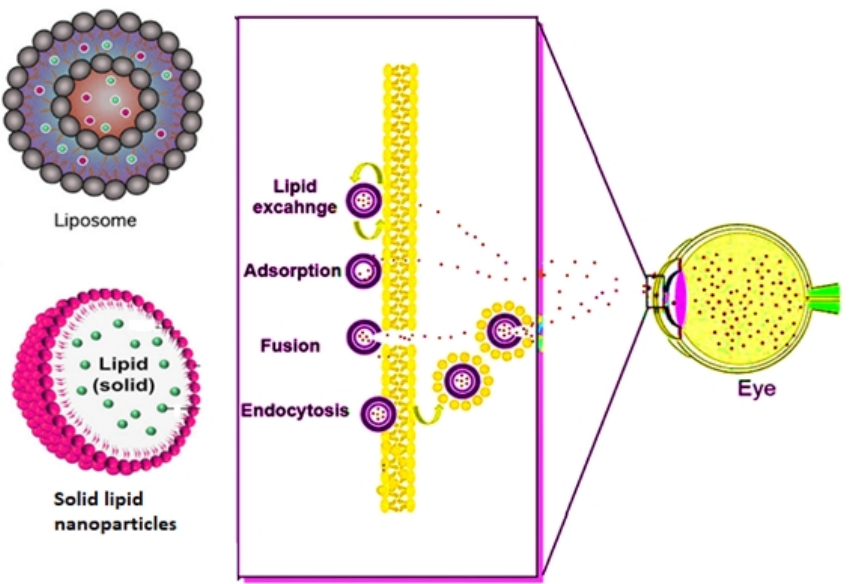
Figure 3. Mechanism followed by lipid and polymeric nanocarriers in overcoming the ophthalmic barrier .